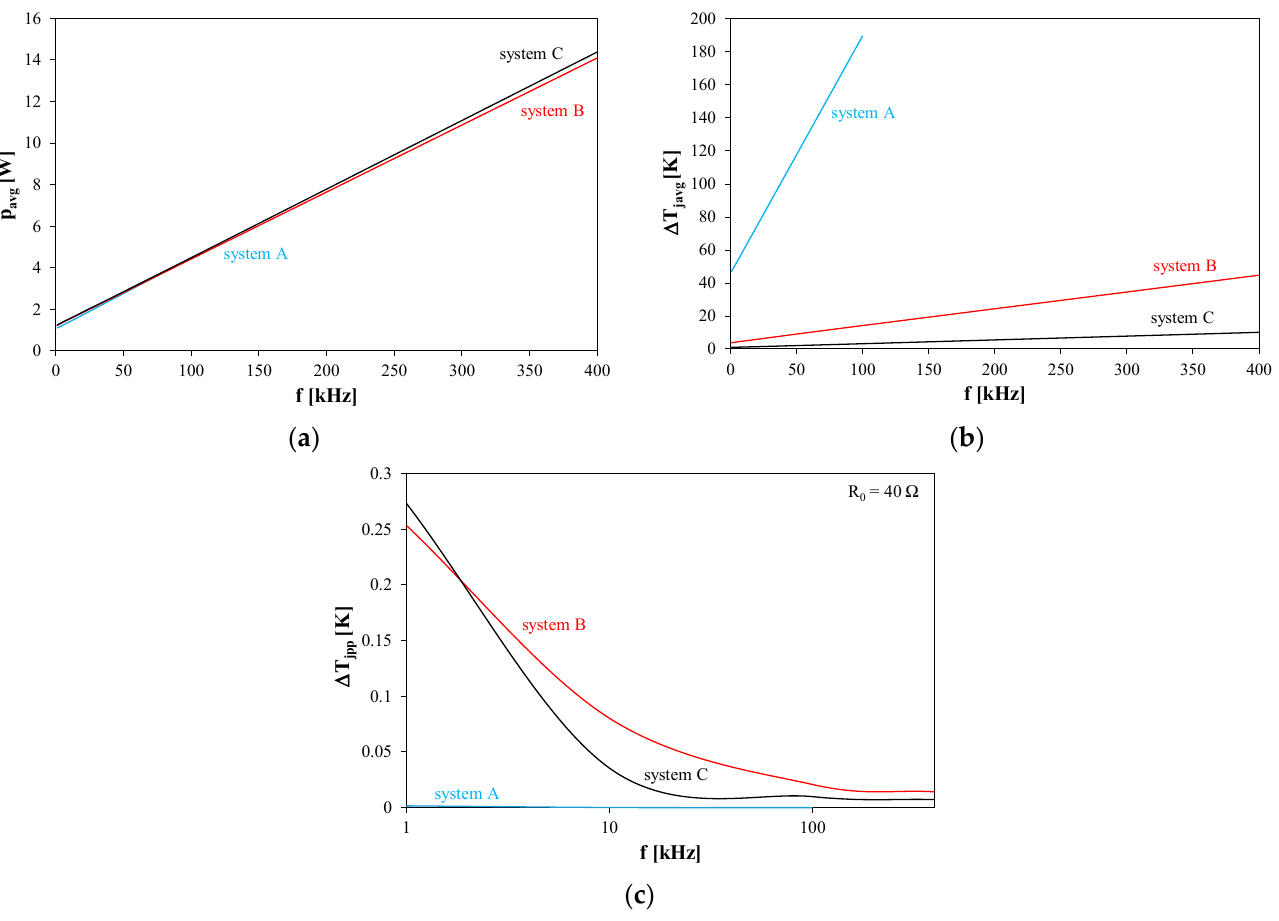
Figure 9. Waveform of the junction temperature at the steady state for the transistor operating in the switch circuit and cooperating with the cooling system C at frequency f = 1 kHz and load re- sistance R 0 = 4 Ω .